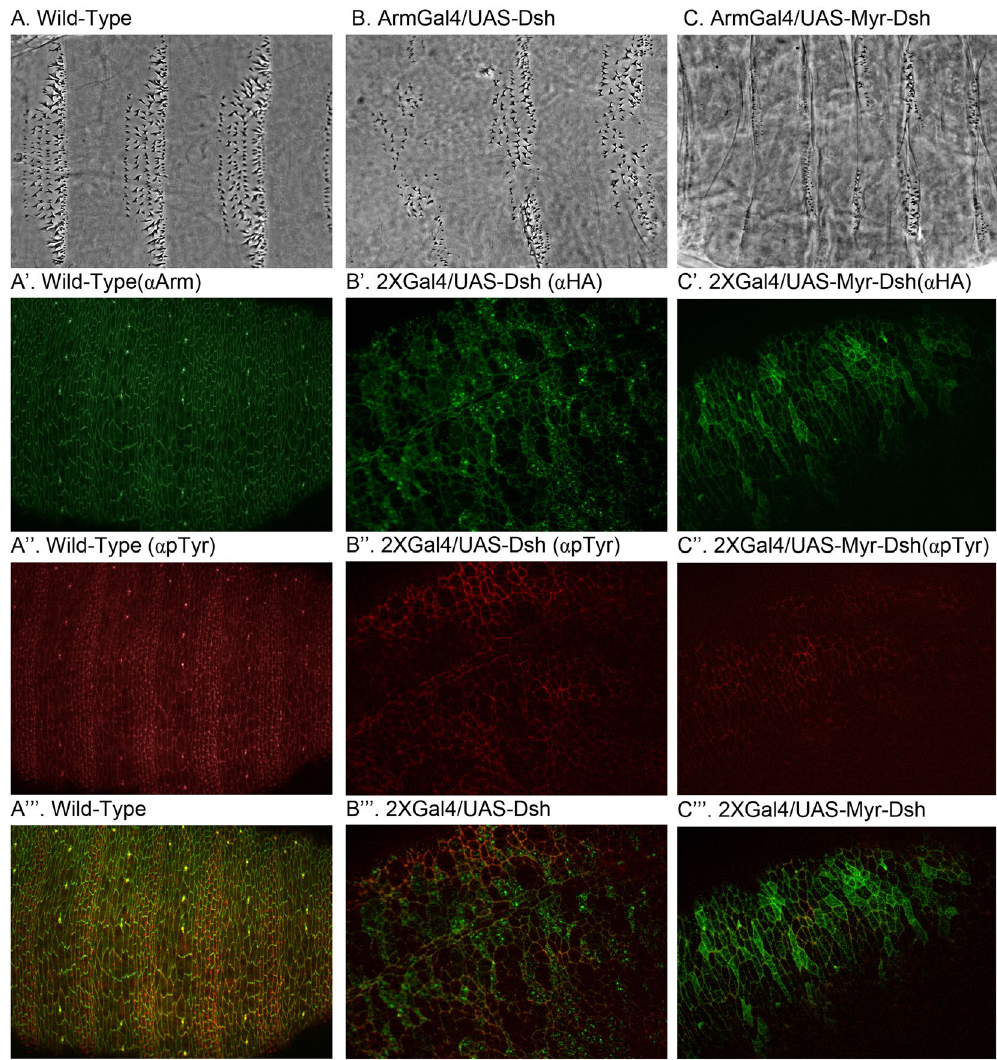
Figure 1. Cuticle preparations of ( A ) Wild type embryo showing six rows of denticles per segment. ( B ) Embryo expressing Dsh resulting in expansion of naked cuticle causing loss of one or two rows of denticles. ( C ) wild type embryo expressing Myr-Dsh showing signaling activation phenotype (GOF). To increase expression levels, we doubled embryonic Gal4 by combining daGal4 and ArmGal4 into a 2XGal4 line. (A’-A”) Wild-type embryo stained for Arm and denticle precursors (pTyr). (B’-B”) Embryo overexpressing Dsh stained for ectopic tag HA and denticle precursors (pTyr). Similar staining in wild type embryo expressing Myr-Dsh (C’-C”).”’ panels show merged